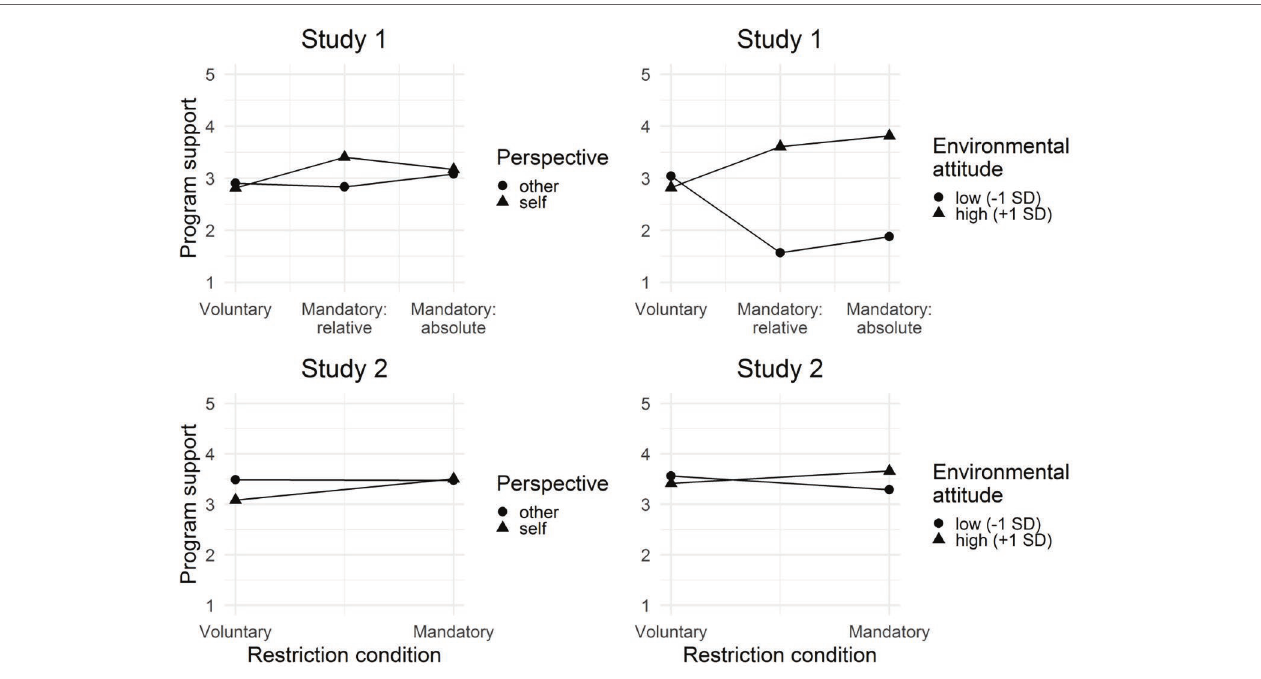
FIGURE 3 | Mean evaluations of the environmental program initiative by freedom restriction condition (Study 1: voluntary, mandatory: relative, mandatory: absolute; Study 2: voluntary, mandatory) and perspective-taking condition (imagine-other, imagine-self) and by environmental attitude (low, high friendliness).